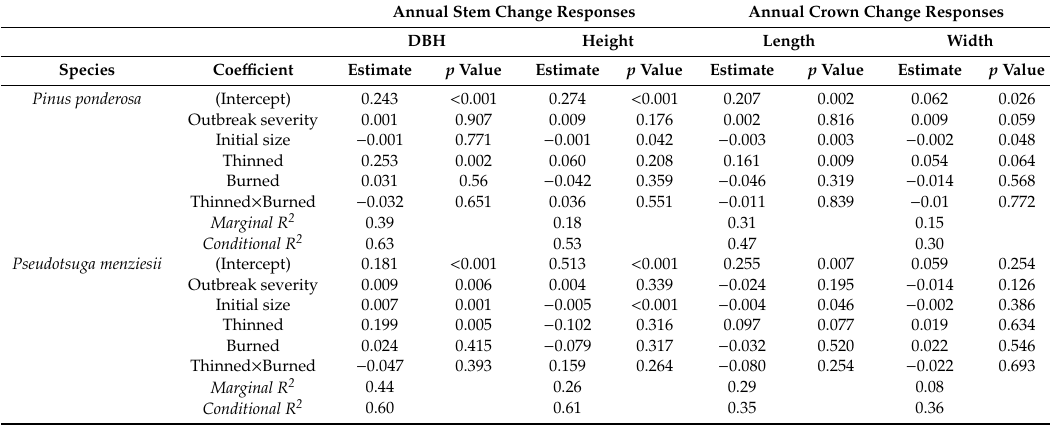
Figure 3. Stem and crown dimensions by treatment and year for Douglas-fir greater than 25 cm dbh. Table 4. Linear mixed-e ff ects model coe ffi cients for individual tree (DBH > 25 cm) periodic annualized growth responses (i.e., change in DBH, height, crown length, and crown width). The “(Intercept)” coe ffi cient refers to the Control treatment. Note that the “Thinned” factor refers to Thin-only and Thin + Burn treatment units, while the “Burned” factor refers to Burn-only and Thin + Burn treatment